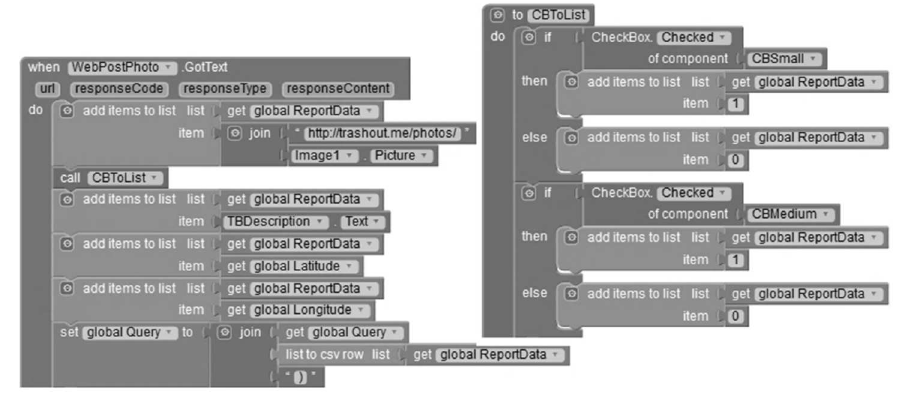
Figure 2. Part of the model in App Inventor from task T2